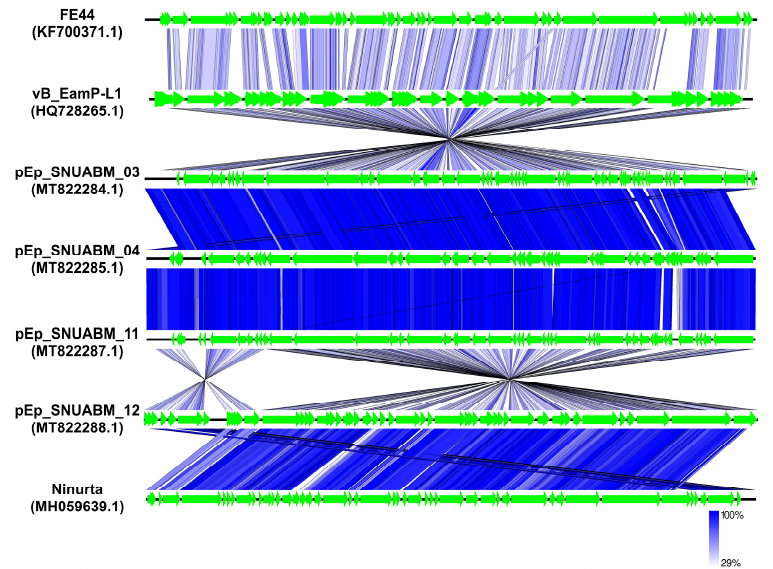
Figure 6. Comparative whole-genome analysis of Erwinia phages pEp_SNUABM_03, pEp_SNU- ABM_04, pEp_SNUABM_11, and pEp_SNUABM_12 among phages infecting Enterobacterales